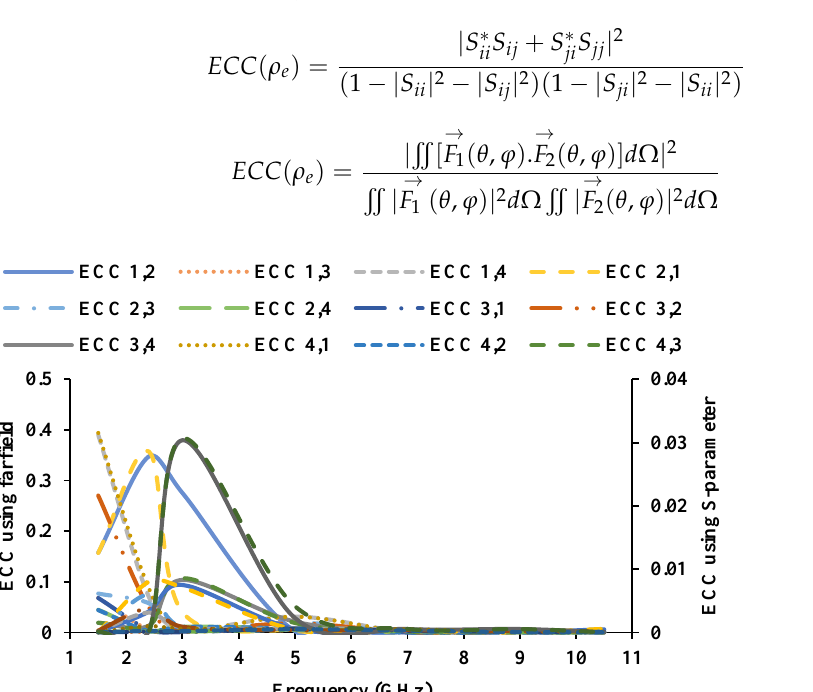
Figure 13. Measured gain and efficiency of the designed antenna.